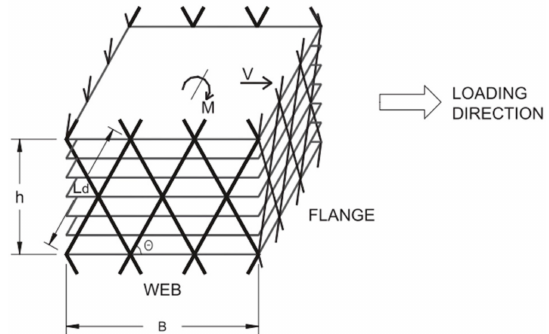
Figure 4. Scheme of the elementary diagrid module for the definition of the sti ff ness-based approach to the diagrid preliminary design. Used with permission from Moon et al.